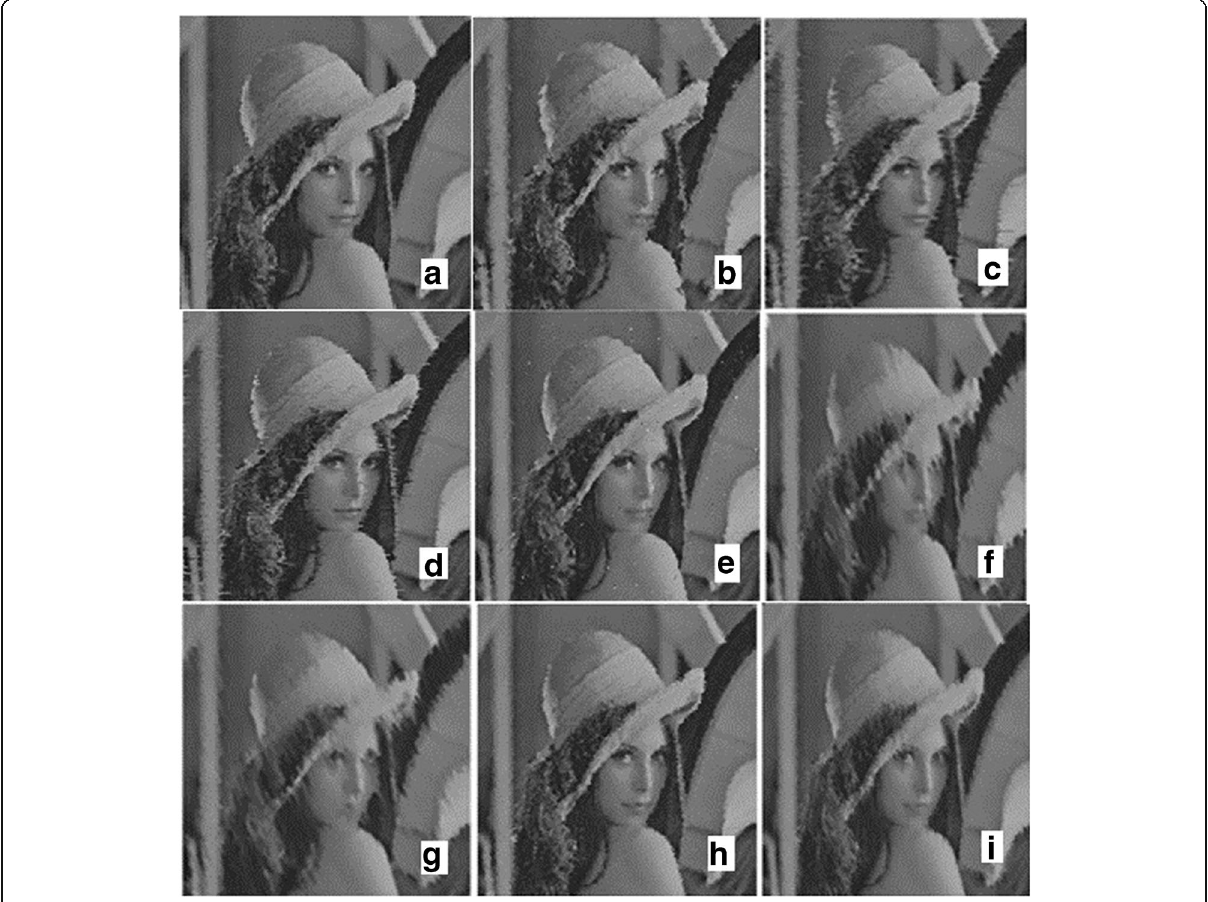
Fig. 10 Performance of various algorithms corrupted by 90% salt and pepper noise on Lena image a DBIDWIF, b AMF (Wmax = 39), c DBA, d IDBA, e NAFSM, f MDBUTMF, g MDBUTMF-GM, h ACBSA, and i AWMF (WMAX =